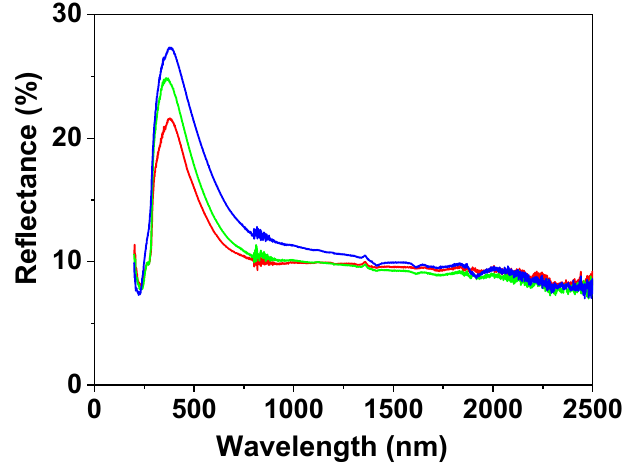
Figure 6. Light reflection versus wavelength for: BMIMPF 6 /NPAS (red solid line), BMIMPF 6 /NPAS